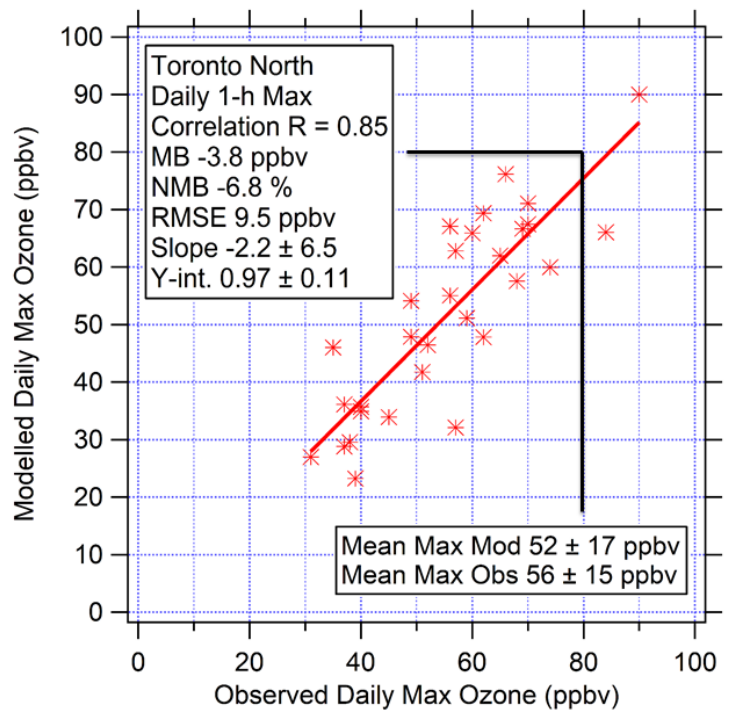
Figure 6. Scatterplot of modelled vs. measured daily 1-h O 3 maximum at the North Toronto site for each day in July 2015. The red line is the linear best fit. The dark lines indicate the 1-h Ontario standard.